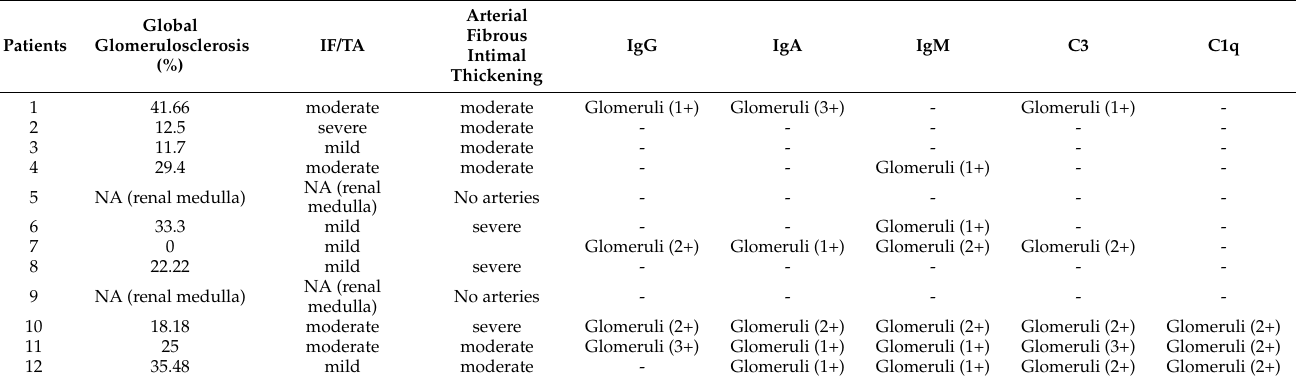
Table 3. This table summarizes the chronicity index and the immunofluorescent findings of our patients’